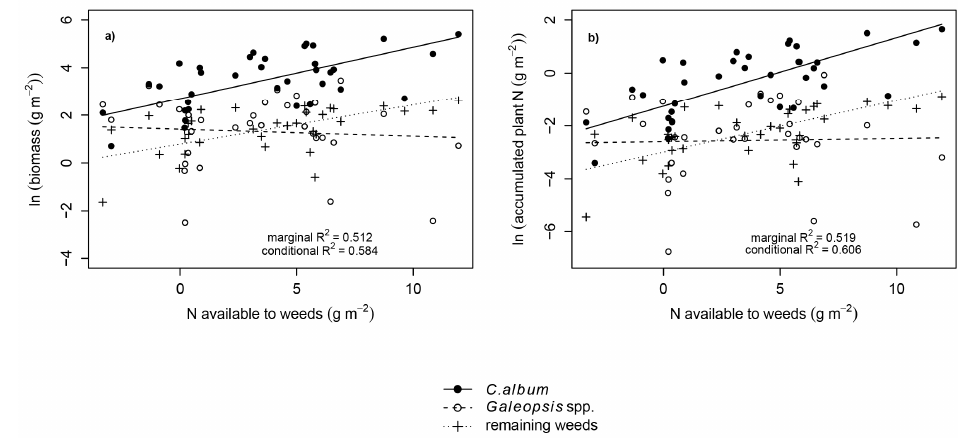
Figure 4. The biomass ( a ) (N availability p = 0.001, species p = 0.001, N availability × species p = 0.002) and N accumulation ( b ) (N availability p = 0.001, species p = 0.001, N availability × species p = 0.002) of different weed species or groups of weeds as functions of the N availability. The regressions are averaged over the sampling times due to non-significance of this factor. Marginal R 2 : variance explained by the fixed effects only; conditional R 2 : variance explained by fixed and ran- dom effects. Negative values are due to the calculation using unfertilized sole-crop barley plots as reference for the inte- grated seasonal N availability. In the respective plots more soil/fertilizer N was taken up by the crop than in sole-crop barley. Table 4. Slope estimates and 95% confidence intervals for the regressions of weed species biomass and accumulated N over N availability presented in Figure 4. Different letters indicate significant different slopes following a pairwise comparison (Tukey, α = 0.05).